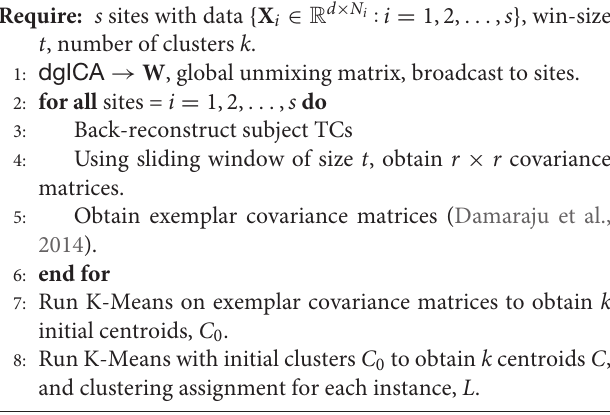
Algorithm 7 Decentralized dFNC algorithm ( ddFNC